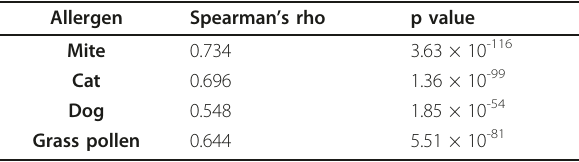
Table 3 Correlation between SPT-WMD (mm) and sIgE levels (kU A /l) for each allergen